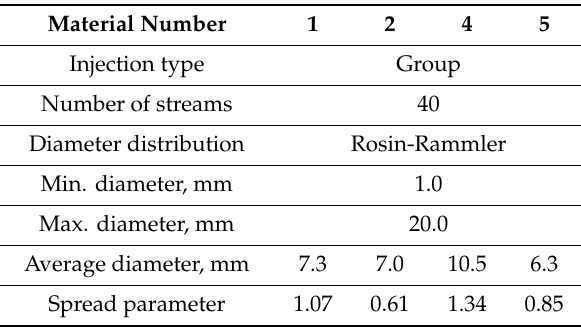
Table 3. Discrete phase model (DPM) injection details.